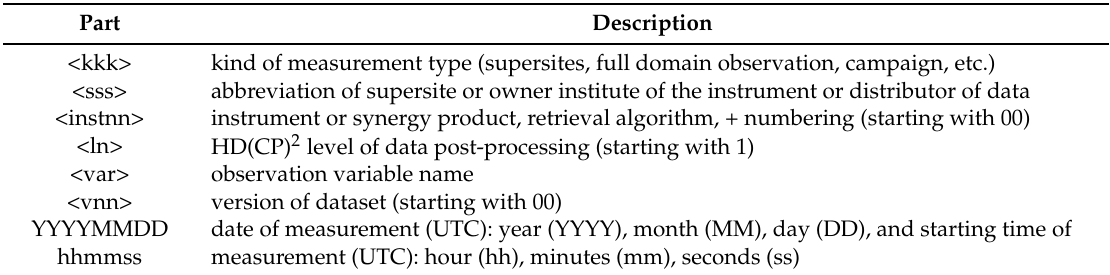
Table 1. Composition of the HD(CP) 2 data file names and description of each file name